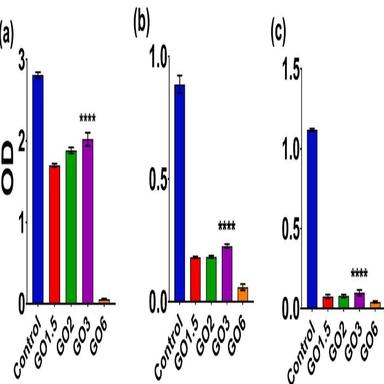
Diagrams Illustrating Microorganism Anti-Biofilm Test Results: The experimental diagrams demonstrate the efficacy of nanomaterials in inhibiting biofilm formation for a) PseA biofilm, b) StaA biofilm, and c) CanA biofilm. The control group represents the untreated samples, and the graphs depict the Optical Density (OD) measurements. Statistical analysis indicates a significant difference (p < 0.0001) compared to the control group.